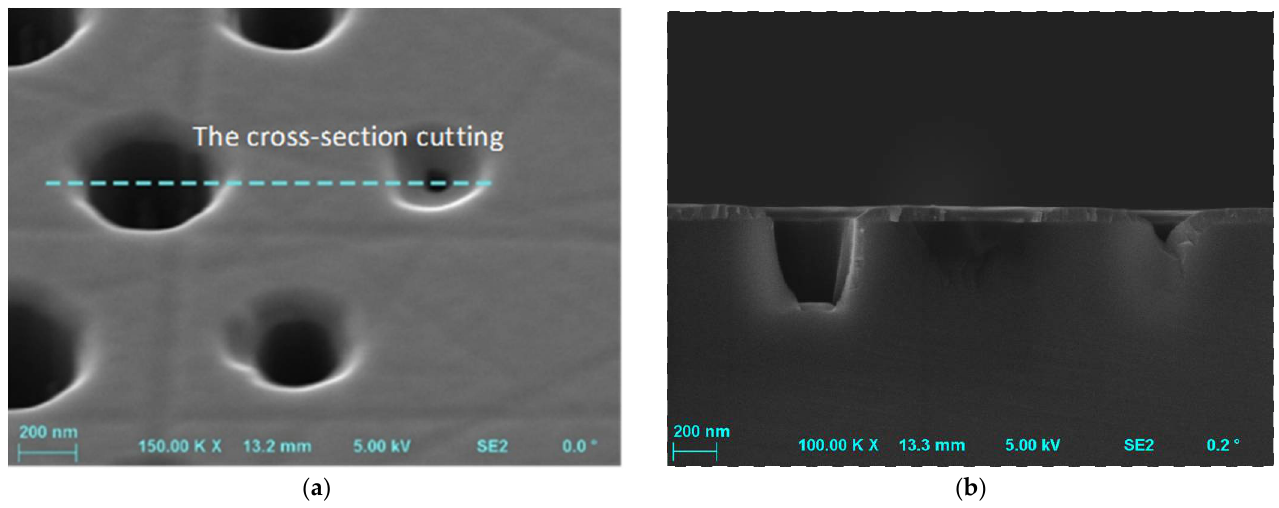
Figure 8. ( a ) The pattern after SiC etching process with parameters: O 2 flow rate = 2 sccm, SF 6 flow rate = 20 sccm, P RIE = 100 W, P ICP = 1300 W, p = 10 mTorr, t = 10 min. ( b ) The cross-section of the pattern shown in ( a ). The relationship between the mask opening width and the etched depth is visible, thus confirms the microloading effect. Designed diameters were 420 nm and 220 nm for indicated in ( a ) left and right holes, respectively.